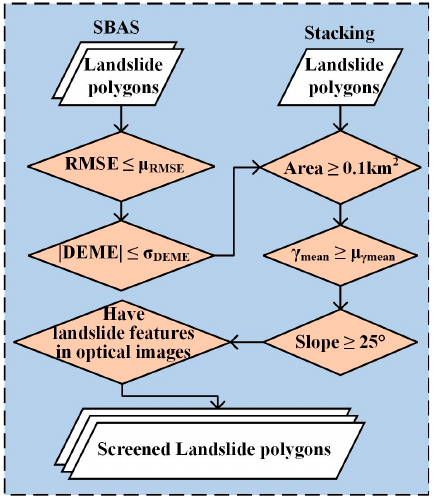
Figure 4. Landslide screening model.